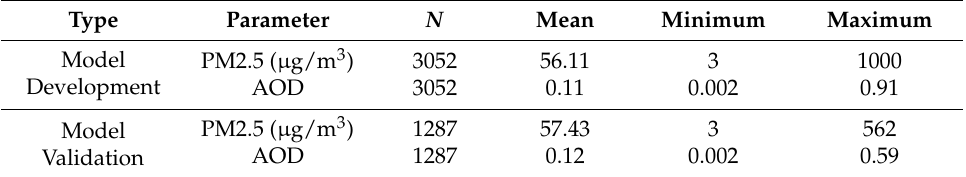
Table 1. Summary statistics of PM 2.5 concentrations and PARASOL level 2 AOD